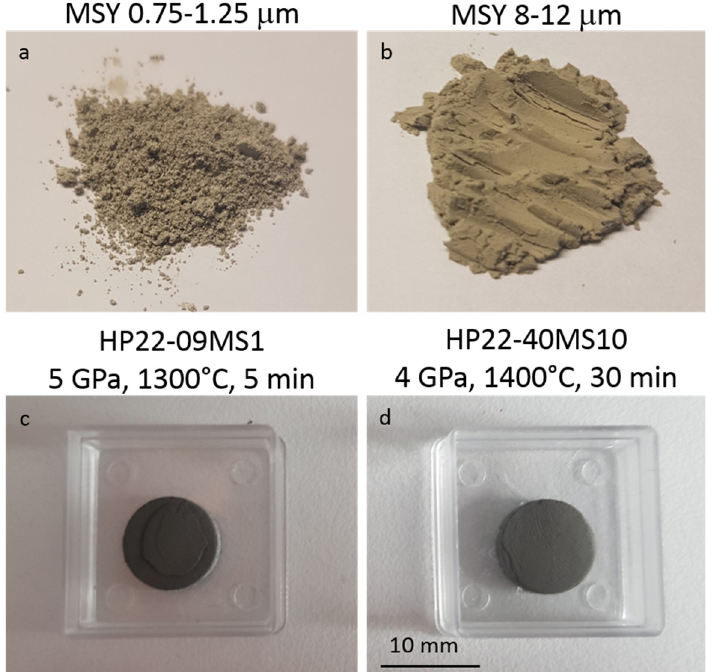
Figure 6. Macroscopic view of starting materials ( a , b ), with grain size 0.75–1.25 μ m ( a ) and 8–12 μ m ( b ), respectively. Starting powders are yellowish. Bottom row shows recovered samples after experiments at HP-HT using our UHP-SPS setup and powders described above ( c , d ). Recovered samples are solid discs of 11 mm diameter and 2–3 mm thickness.